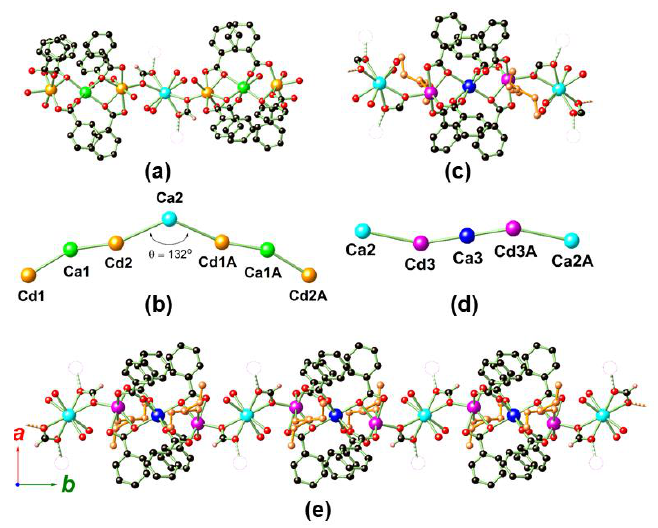
Figure 2. The structures of the discrete V-shaped heptanuclear cluster ( a , b ) and 1D rod-shaped ( c – e ) subunits in MOF 1 , showing the full coordination geometry around each metal ( a , c , e ), and the framework skeleton represented by only metals ( b , d ). In ( a ), dashed bonds with blank spheres indicate that the heptanuclear cluster is orthogonally associated with the 1D rod-shaped chain via a pair of HCOO with µ 3 - η 1 : η 1 : η 2 coordination, and vice versa ( c , e ). All disordered components, dissociated DEF solvate, and hydrogen atoms (except those on HCOO) are omitted for clarity. Color legend: C: black, H: light pink, O: red, Cd1 / Cd2: orange, Cd3: magenta, Ca1: green, Ca2: cyan, Ca3: blue. The coordinated DEF solvates in ( c and e ) are further distinguished with orange color for clarity. Symmetrical code